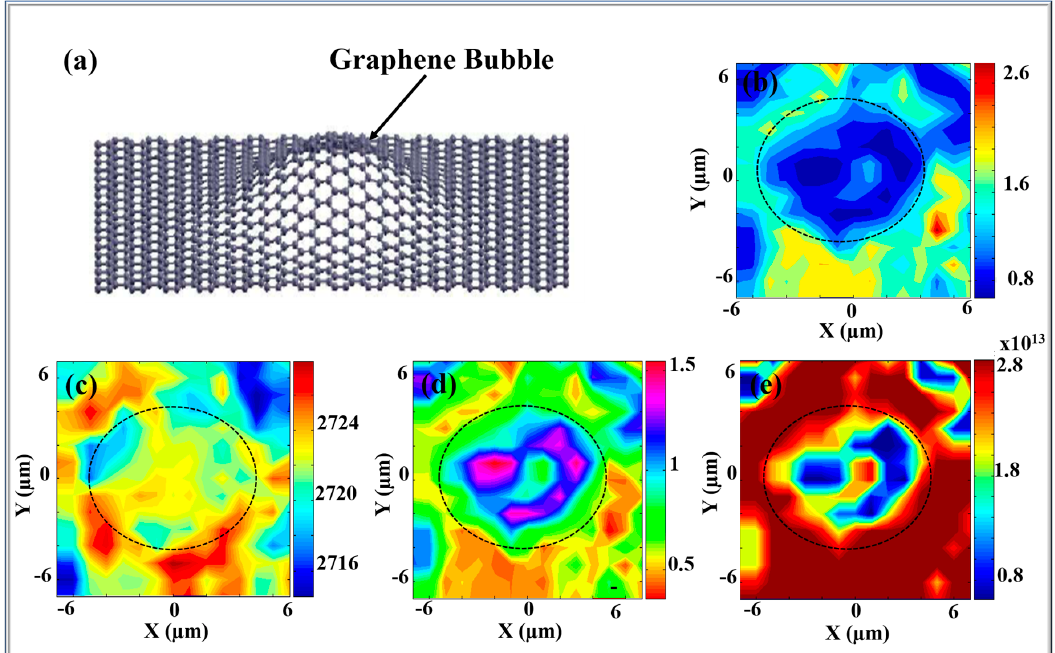
Figure 10. ( a )—Schematic image of a graphene bubble [134]. Line mapping trajectory is indicated. The Raman mapping of: ( b )—the intensity ratio I G /I 2D , ( c )—the Raman shift position of the 2D band, ( d )—the intensity ratio of I 2D /I G and ( e )—the density of charge. The external perimeter of the bubble is shown in a dashed line in ( b , e ) [16].